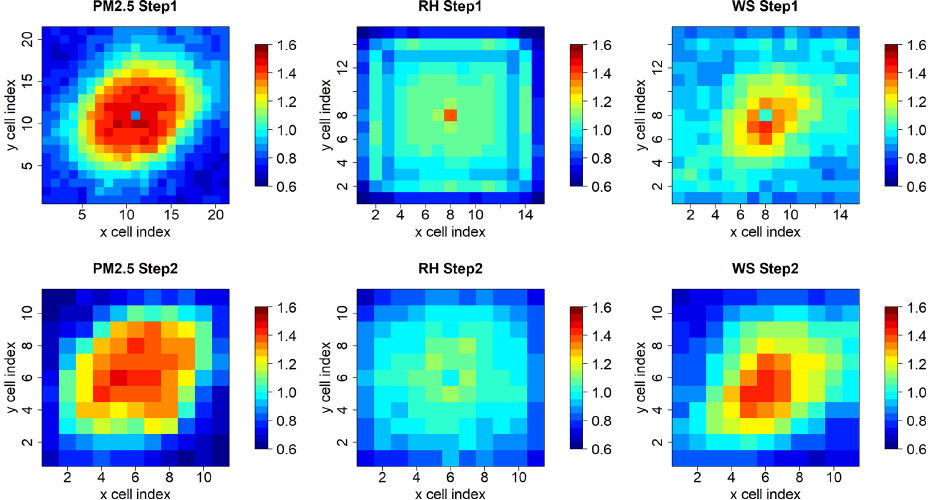
Figure 3. PointConv filters for PM 2 . 5 , RH, and WS.